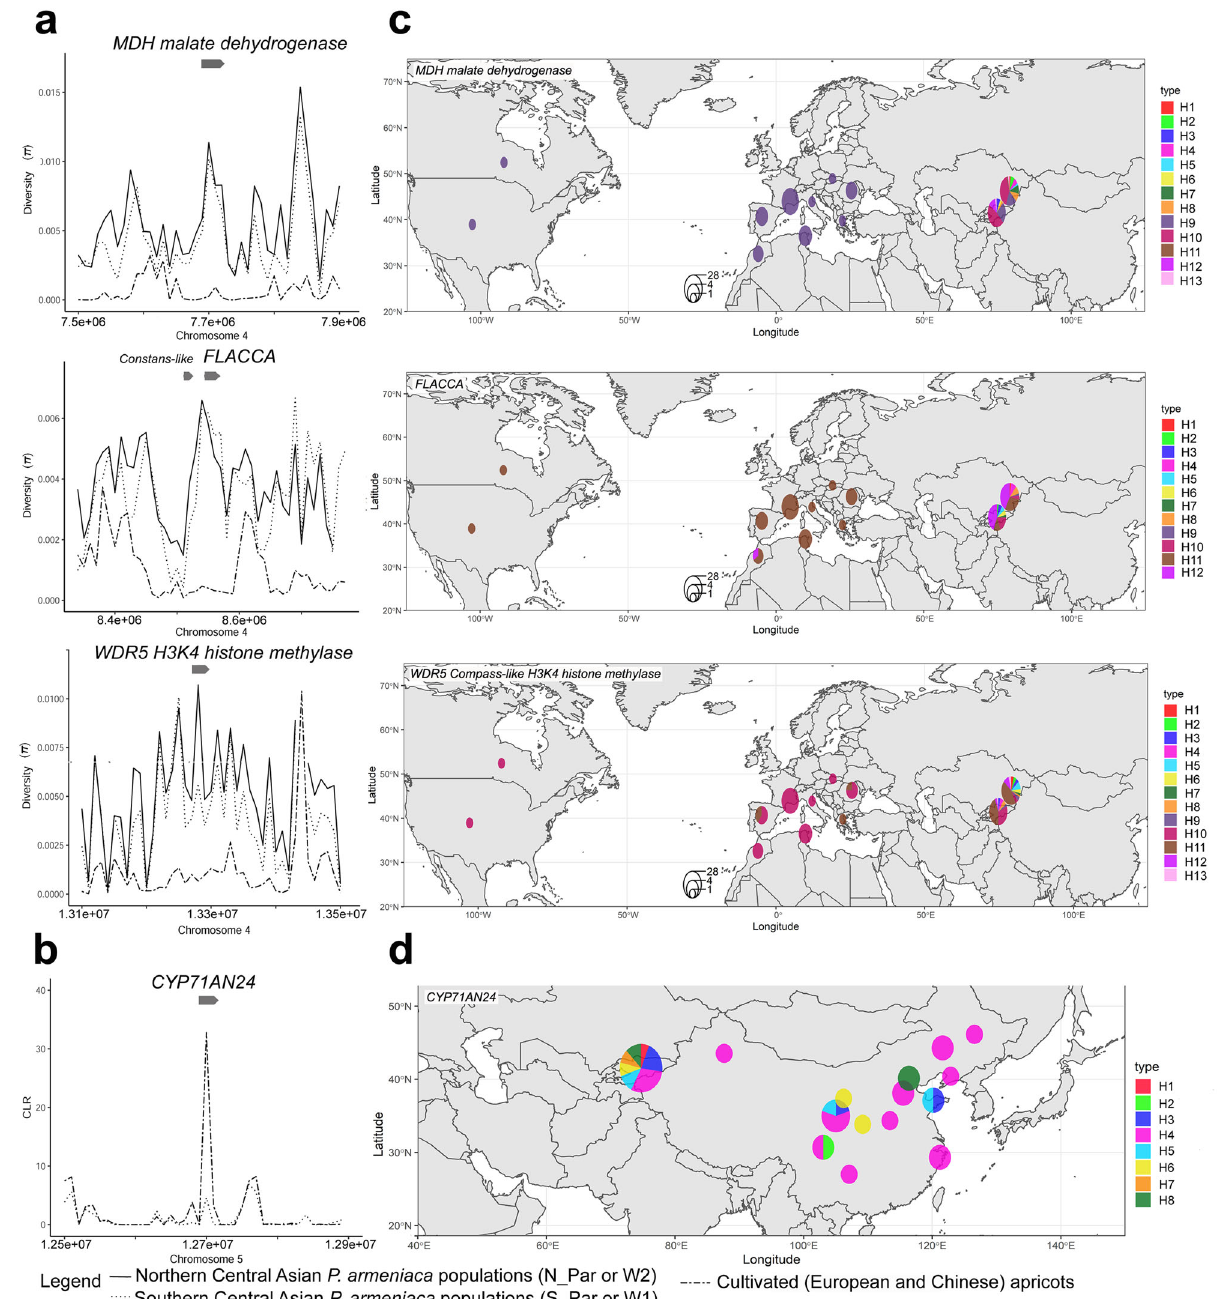
Fig. 7 Examples of four genes with footprints of positive selection. Nucleotide diversity ( a ) composite likelihood ratio ( b ) and haplotype distribution of four candidate genes under selection during the domestication of European ( c ) or Chinese ( d ) apricots. a Nucleotide diversity ( π ) plots and ( c ) geographic distribution of alleles at malate dehydrogenase (MDH) , FLACCA and WD-repeat protein-5 ( WDR5 ) loci in European apricots and Northern and Southern Central Asian P. armeniaca natural populations. b Composite likelihood ratio and ( d ) geographic distribution of alleles at the cytochrome P450 71AN24 ( CYP71AN24 ) locus in Chinese apricots and Southern Central Asian P. armeniaca natural populations. Grey arrows at the top of the plots indicate the position of the candidate genes; black line, Northern P. armeniaca wild natural populations (W2 or N_Par); dotted line, Southern P. armeniaca wild natural populations (W1 or S_Par); broken line, cultivated European or Chinese apricots. See Fig. 6b for diversity scans across the whole chromosome 4. Note that the Constans-like haplotype distribution is similar to the FLACCA haplotype distribution, being very close (22 Kb apart) over the interval. H1 to H13 refer to the haplotypes identi fi ed in wild and cultivated apricots. For all panels, the different haplotypes of the focal gene are represented by different, arbitrary colors. The world map layout was generated by the ggplot2 R package. Source data underlying Fig. 7c and 7d is provided as a Source Data fi